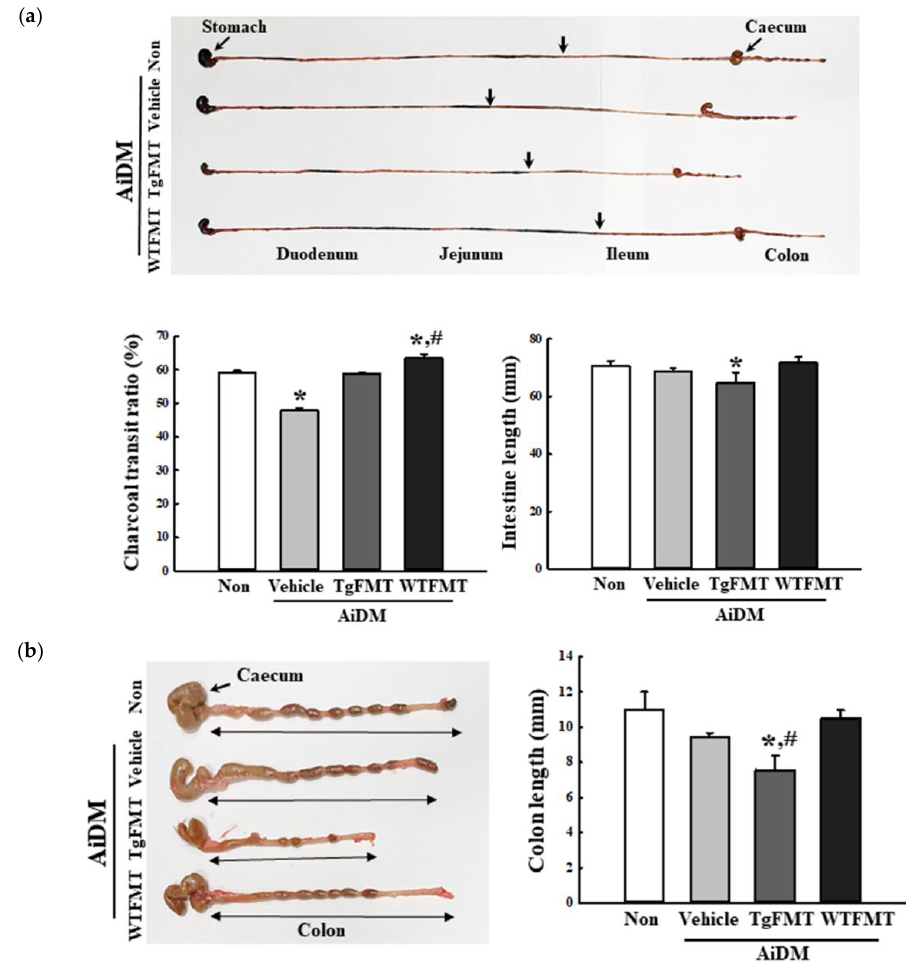
Figure 6. GI transit ratio and colon length in the AiDM+TgFMT group. ( a ) GI transit ratio of the charcoal meal and the length of the colon. After collecting the GI track from AiDM+TgFMT and AiDM+WTFMT groups treated with charcoal meal, the GI length and the distance traveled by the charcoal meal were measured using a ruler. The arrows indicate the position of the charcoal meal. ( b ) Colon length. After harvesting the colon from the total GI track, the colon length was measured similarly. The treatment of charcoal meal powder was prepared from four to six mice per group, and the charcoal meal transit distance and colon length were measured in duplicate. The data are reported as the mean ± SD values. *, p < 0.05 compared to the Non-treated group. #, p < 0.05 compared to the AiDM+Vehicle